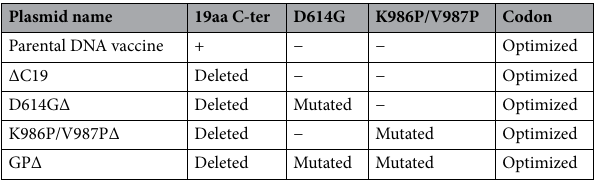
Table 1. The mutations and deletion in modified plasmid